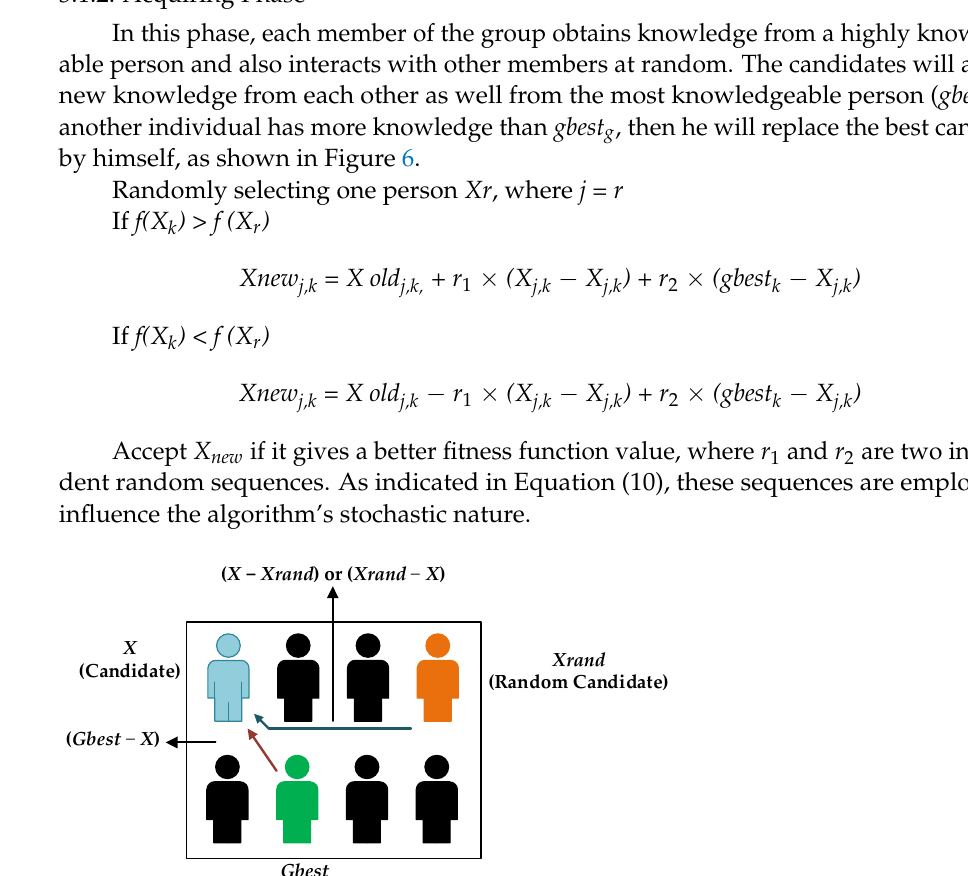
L Mosfet Switch Figure 7. Solar DC–DC converter-integrated SGO–MPPT control. This section explains how to implement the SGO in a step-by-step manner. 3.2.1. Initialization Phase Step 1: Generate random population (Candidate/Duty Cycle). 3.2.2. Improving Phase